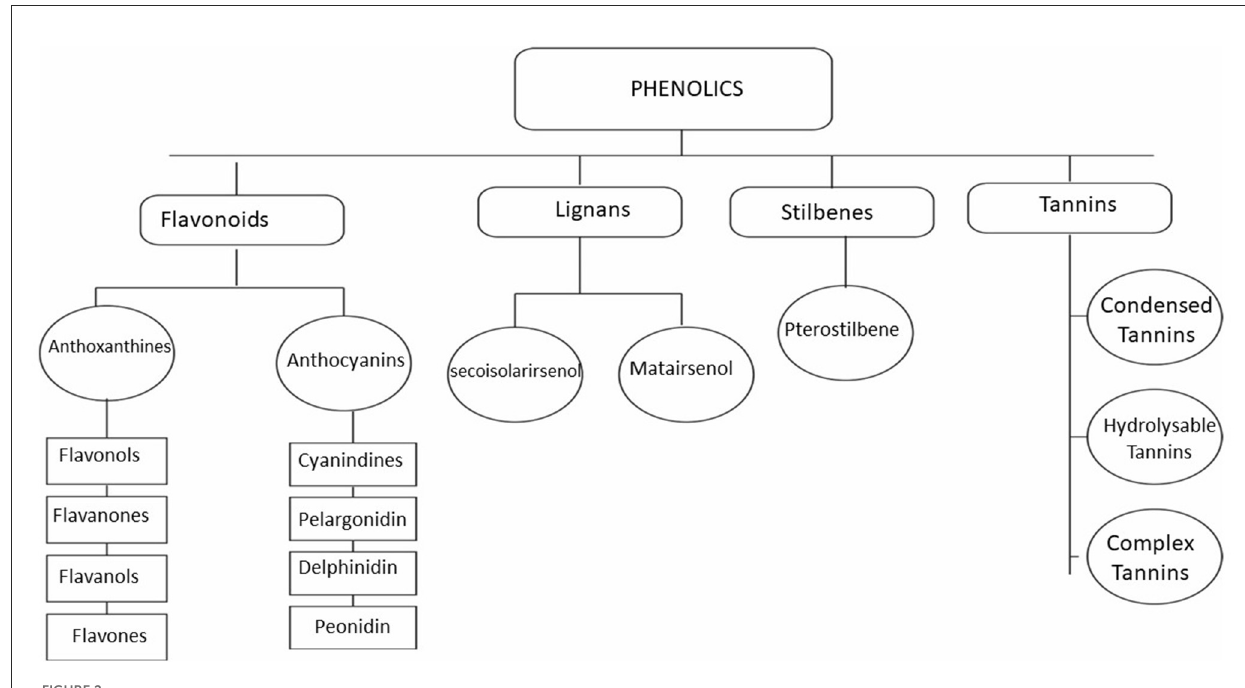
FIGURE2 Classification of